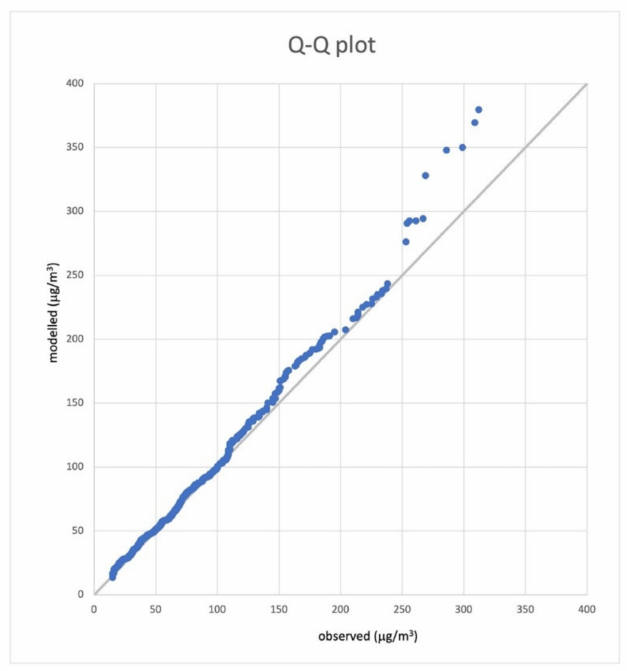
Figure 11. Q–Q plot of modelled vs. observed NOx.